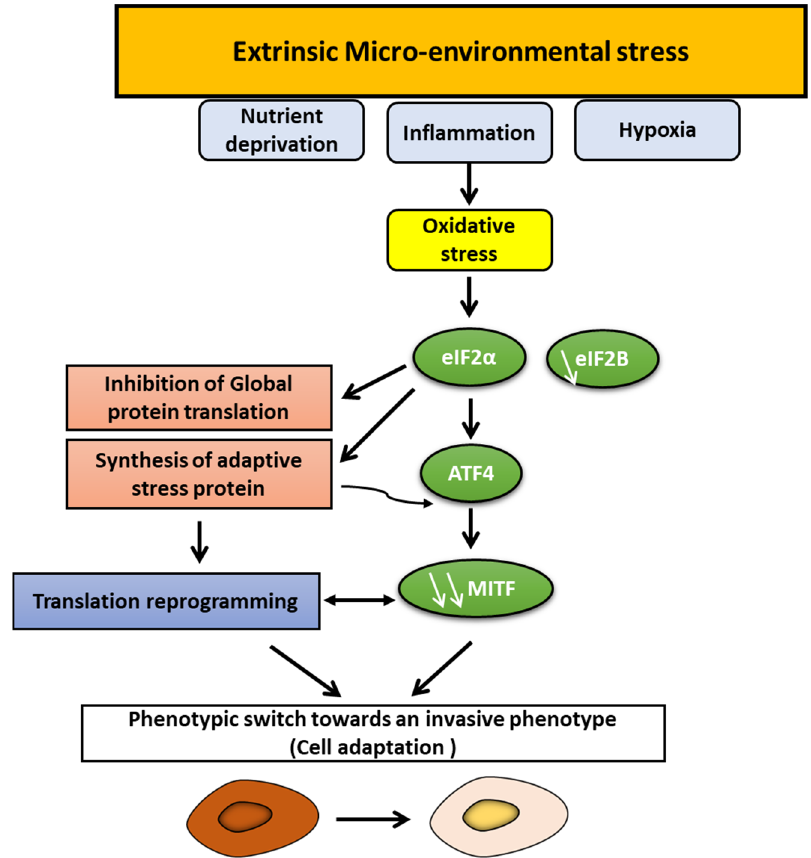
Figure 4. Phenotype switching in melanoma: prominent role of microenvironment stress signals and oxidative stress. Several microenvironmental cues, such as hypoxia, inflammation, and nutrient deprivation, can promote oxidative stress leading to eIF2 α phosphorylation and eIF2B inhibition and, consequently, to the synthesis of adaptive stress proteins, including ATF4, and to the inhibition of global protein translation, which repress MITF. Translation reprogramming and MITF repression can induce a phenotypic switch towards an invasive